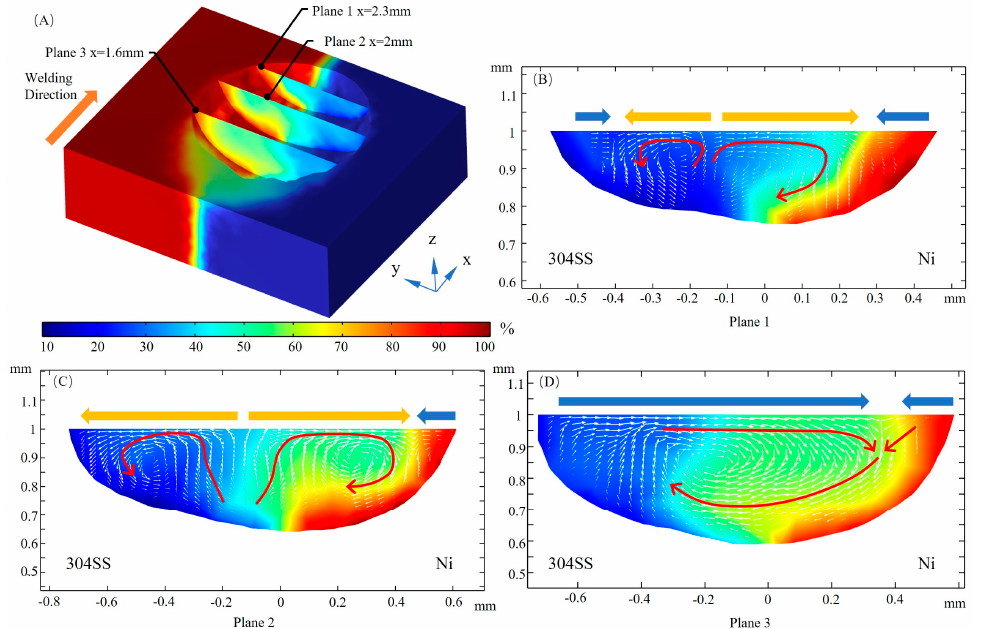
Figure 12. Ni concentration on yz sections. ( A ) 3D view; ( B ) x = 2.3 mm; ( C ) x = 2 mm; ( D ) x = 1.6